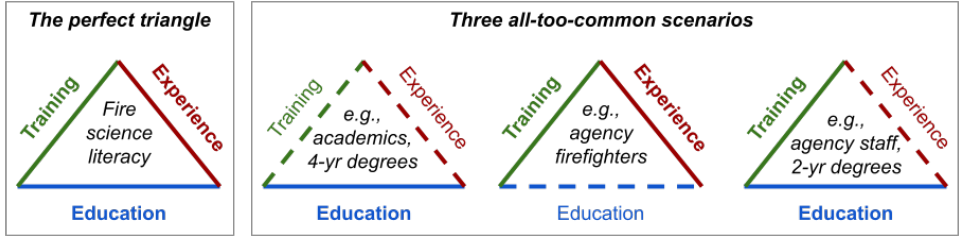
Figure 3. Kobziar et al. [14] identified three components of professional development in the wildland fire community that we identified as essential to developing wildland fire literacy. Unfortunately, all too often, certain syndromes of lopsided professional development persist among various members of the wildland fire